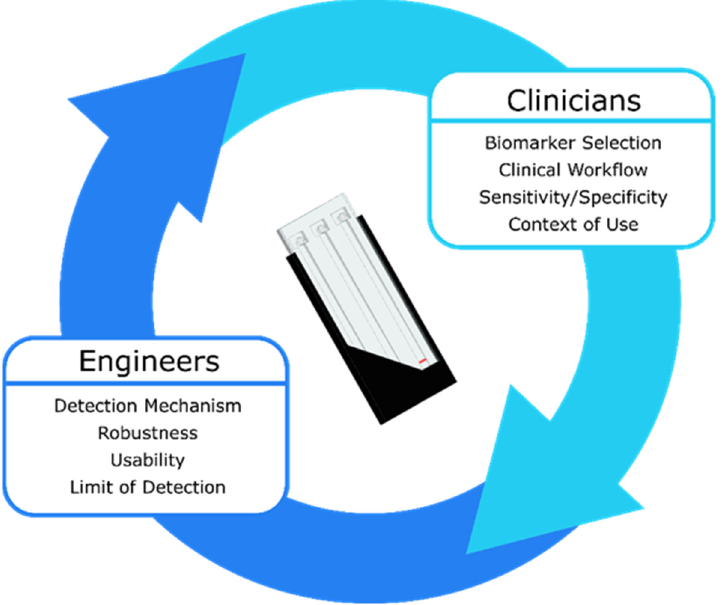
Figure 6. A traumatic brain injury biomarker measurement device can only be developed with constant feedback between clinicians and engineers. The clinical parameters inform the device parameters and vice versa until the optimal device is realized.